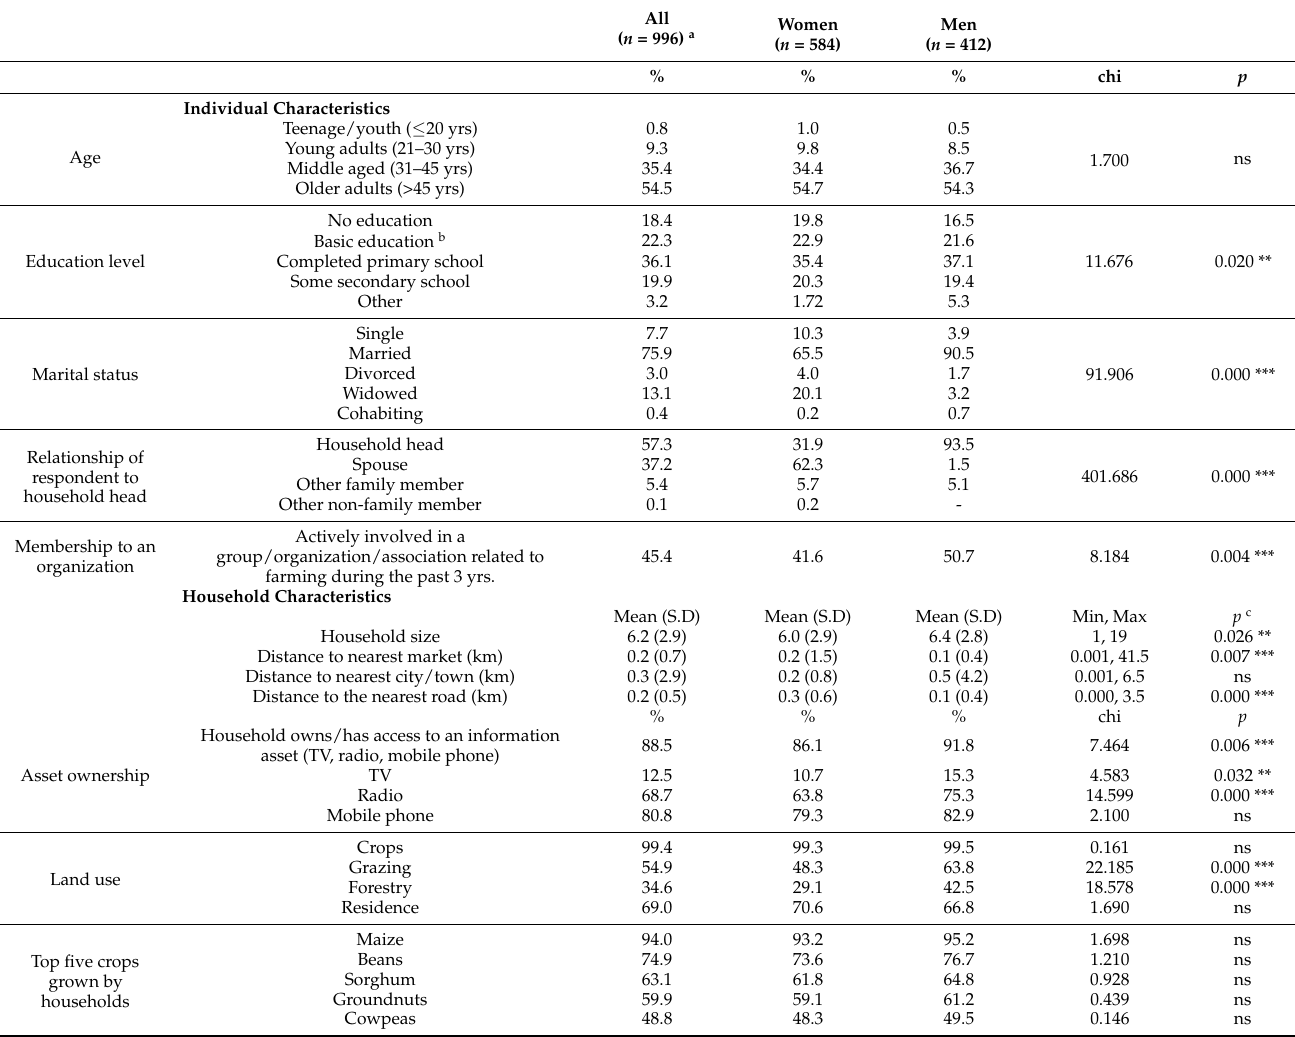
Table A1. Demographic and socio-economic characteristics of survey